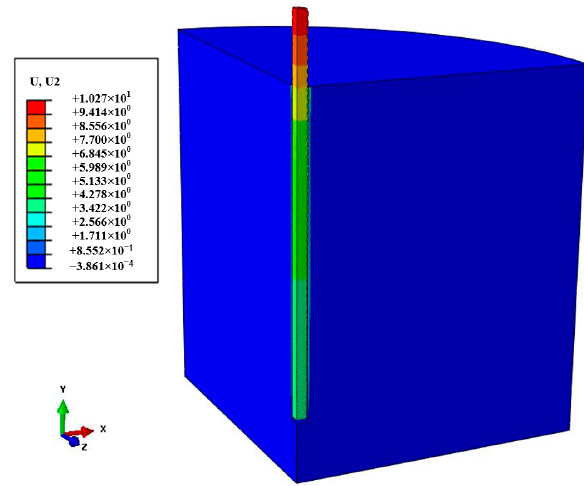
Figure 9. L420 model failure diagram.